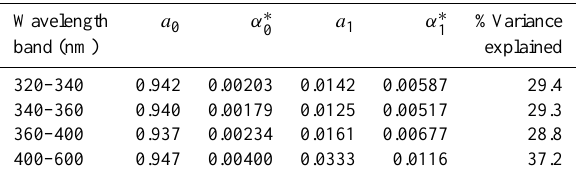
Table 5. Results from the regression